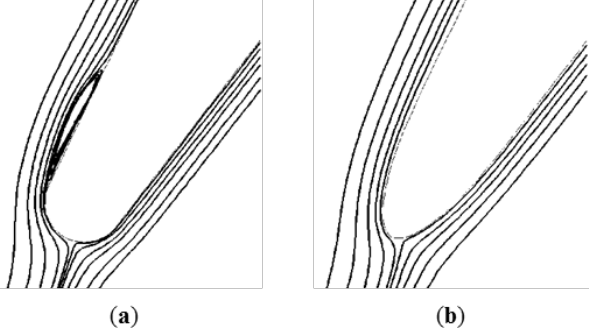
Figure 25. Time-averaged streamlines at mid-span (Re = 5 × 10 5 ): ( a ) circular LE; ( b ) continuous-curvature LE.